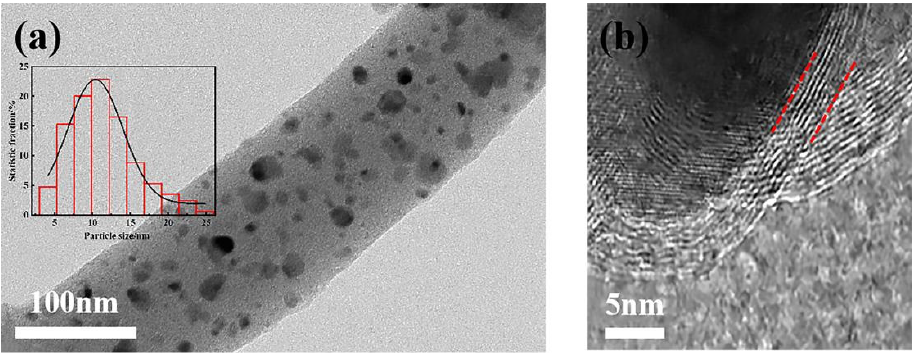
Figure 4. ( a ) TEM image (the inset shows Particle size distribution); ( b ) HRTEM image of Ni 3 Fe 7 @C- CNFs.